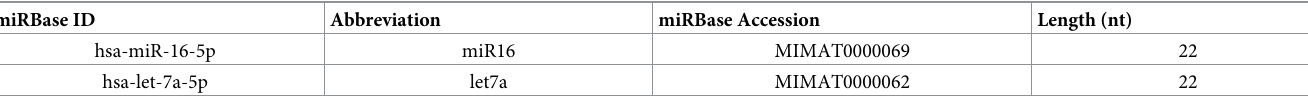
Table 1. List of microRNA species used in this study.